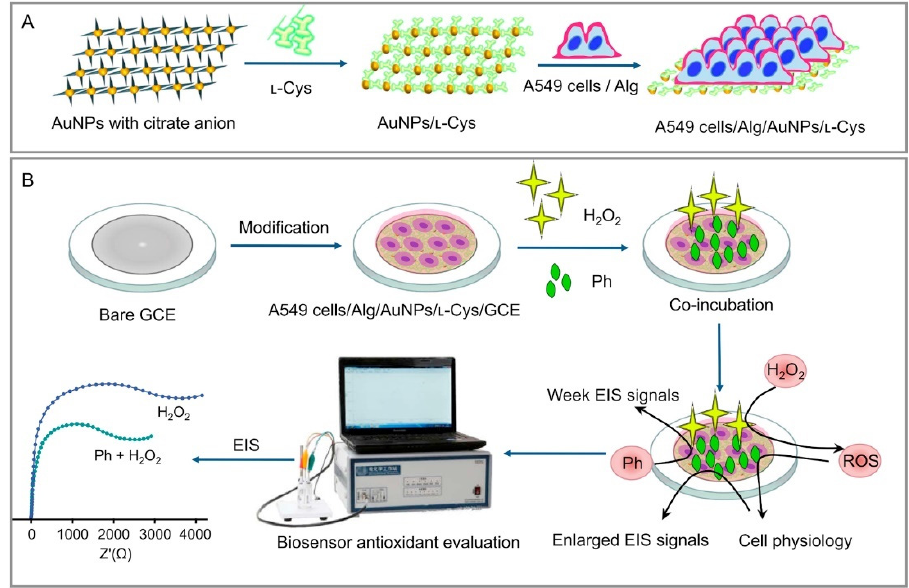
Figure 15. Schematic illustration of the assembly of A549 cell-based sensor ( A ) and of the evaluation process of the PH antioxidant capacity ( B ). Reprinted with permission from [129]. Copyright 2018, Elsevier.